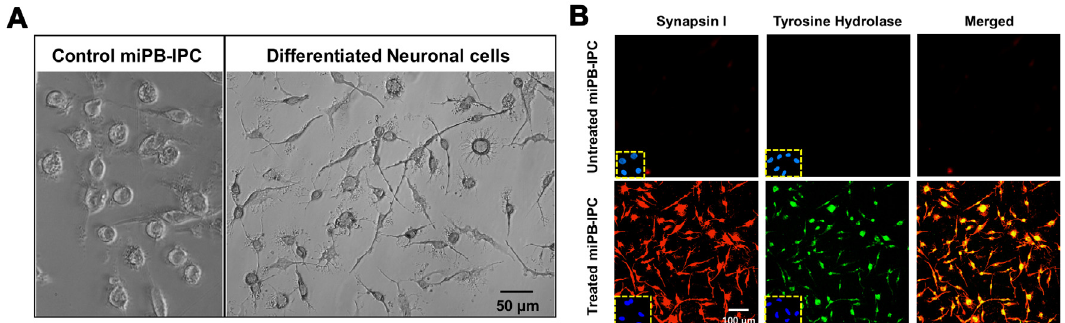
Figure 3. Differentiation of miPB-IPC into neuronal cells. ( A ) Phase contrast images show the differentiation of miPB-IPC into neuronal cells ( n = 5). ( B ) Immunostaining of differentiated neuronal cells with neuron-specific markers synapsin I (red) and tyrosine hydroxylase (green) ( n = 3). IgG staining served as negative control (inserts). Untreated miPB-IPC served as negative control (top panel).